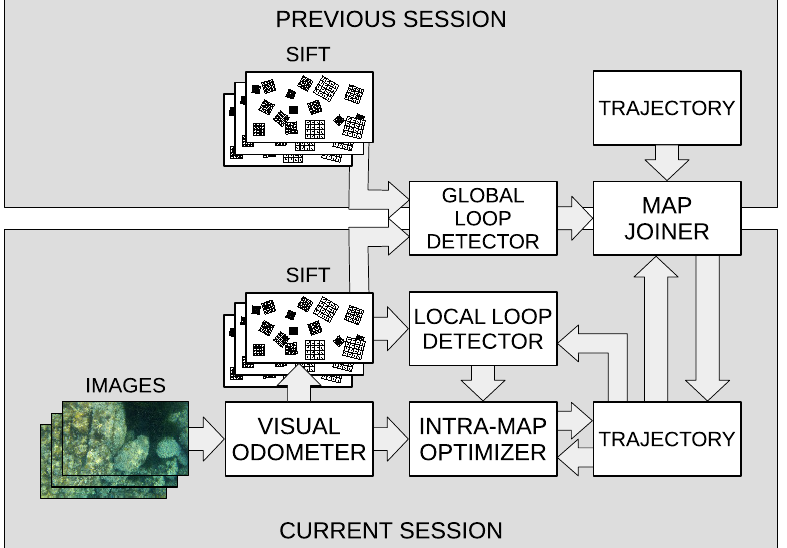
Figure 1. System